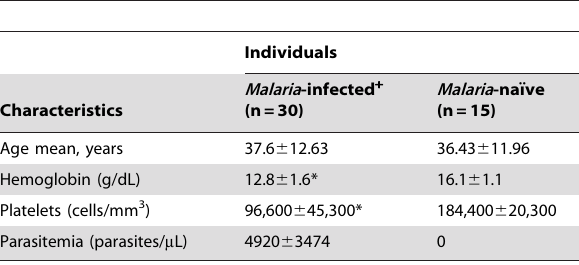
Table 1. Description of the study population by age and hematological parameters (Mean 6